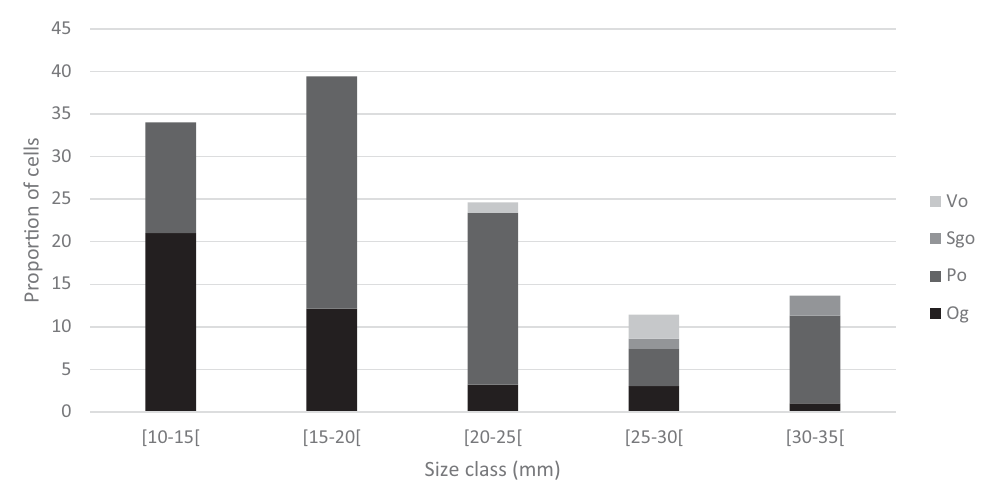
Fig. 7. Cells proportion for different development stages as a function of shell height in females. Og Ovogonia; Po Pre-vitellogenic oocyte; Sgo Secondary growth oocyte; Vo vitellogenic oocyte.